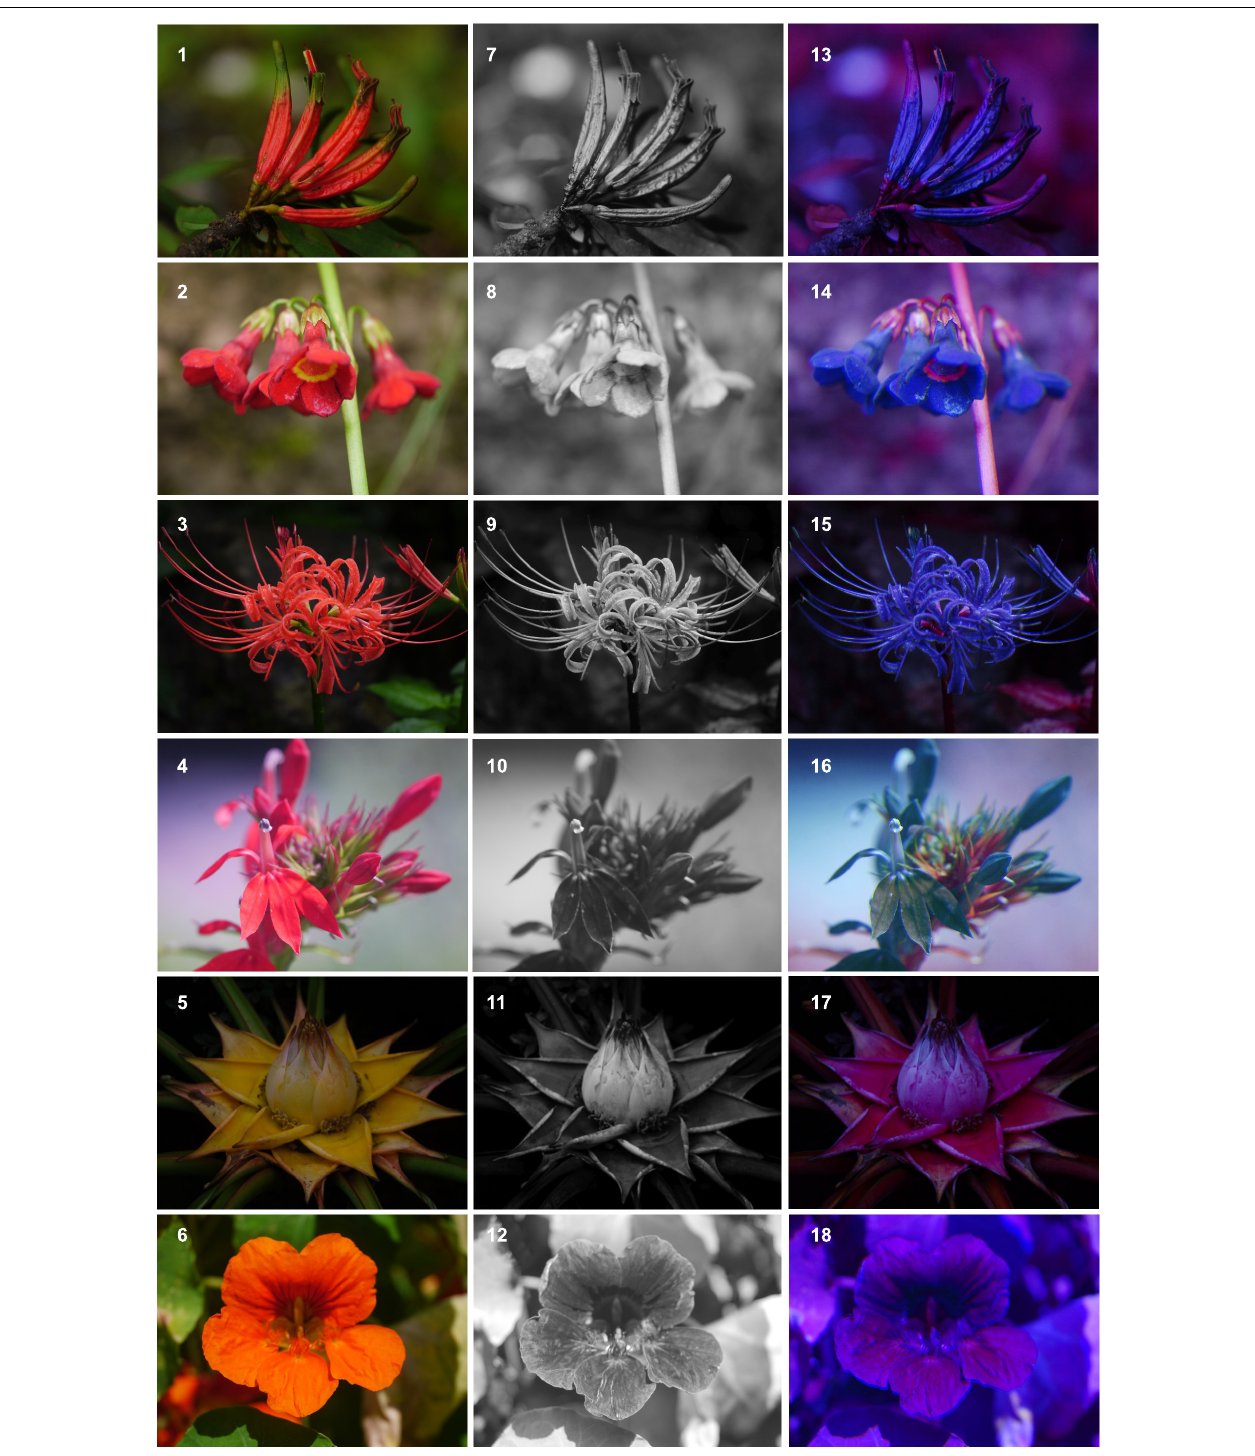
FIGURE 3 | Illustration of flower colors associated with the bird pollination syndrome highlighting the weak visual contrast to the background in bee vision. Color photos show flowers seen by humans (1–7), in ultraviolet (8–12) whereas false color photos in bee view consider the bee-visible range of wavelength and display ultraviolet as blue, blue as green and green as red, and red is discarded, the mixed color ultraviolet-blue is displayed as blue-green, blue-green is displayed as yellow, and purple is displayed as blue (13–18; Verhoeven et al., 2018). See Figure 4 (2,8,14) and Figure 4 (4,10,16) for comparison of background color contrast in a bumblebee-pollinated plant. Illustrated species are by row from top to bottom: Taxillus caloreas (Loranthaceae), Primula anisodora (Primulaceae), Lycoris radiata (Amaryllidaceae), Lobelia cardinalis (Campanulaceae), Musella lasiocarpa (Musaceae), Tropaeolum majus (Tropaeolaceae).